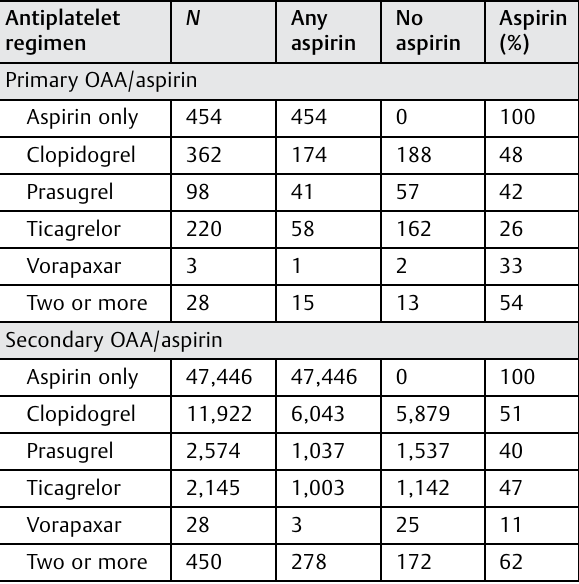
Table 3 Reporting gender with OAA in FAERS Antiplatelet regimen